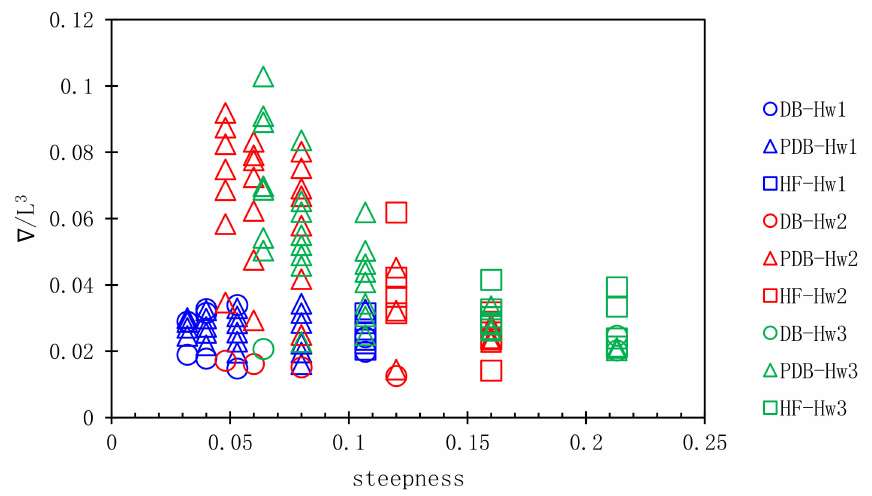
Figure 13. Effect of wave steepness ( ε = H w / L w ) in the non-dimensional green water volumes ( ∇ * = ∇ / L 3